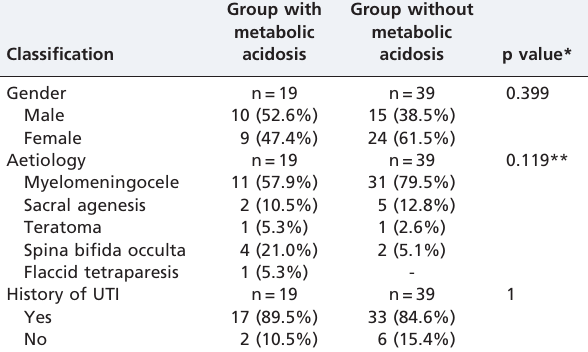
Table 6 - Comparison between the group without metabolic acidosis and the group with metabolic acidosis regarding gender, aetiology of neurogenic bladder and history of UTI.